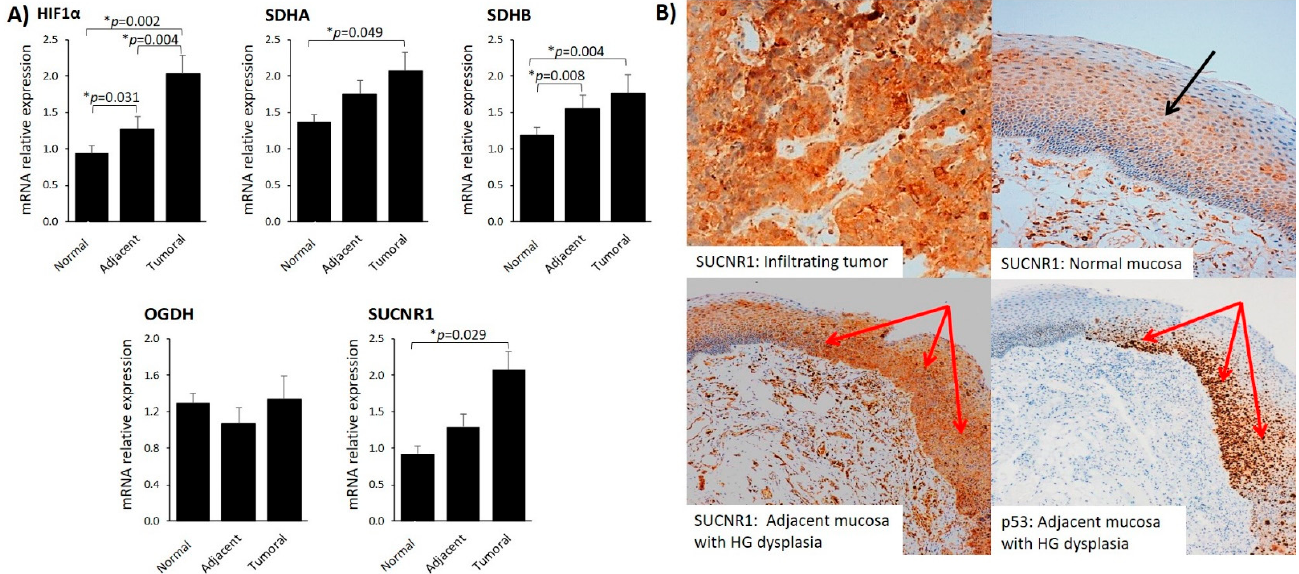
Figure 2. SUCNR1 protein and gene expression is increased in tumors. ( A ) HIF-1 α , SDHA, SDHB, OGDH and SUCNR1 gene expression in normal, adjacent and tumoral mucosa. Gene expression differences between tissue samples were calculated using the Wilcoxon Signed Rank Test for nonparametric-related samples. Results are expressed as mean (SEM). *, Differences were considered statistically significant at p < 0.05. ( B ) Representative images of SUCNR1 immunostaining in infiltrating tumor and normal mucosa. Upper left image: high immunohistochemical expression of SUCNR1 in infiltrating tumor. Upper right image: low immunohistochemical expression of SUCNR1 in normal mucosa (black arrow in spinous layer). Lower left image: high immunohistochemical expression of SUCNR1 in adjacent mucosa with high grade (HG) dysplasia (red arrows). Lower right image: p53 staining highlight the HG grade dysplasia areas in adjacent mucosa (red arrows). Table 2. Correlation Analysis of Circulating Succinate with the Expression of Genes Involved in